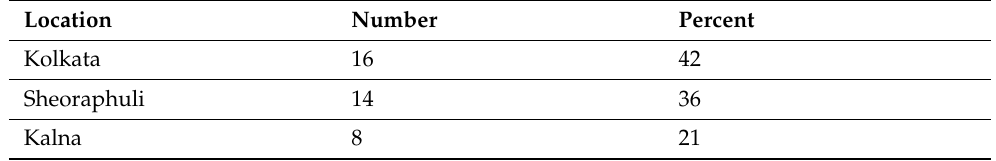
Table 2. The locations of interviewed participants.